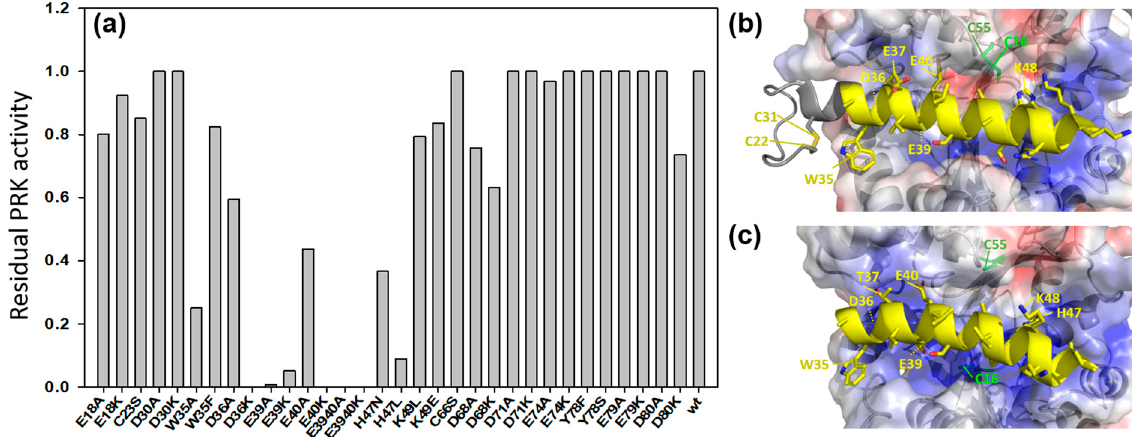
Figure 5. ( a ) Residual activity of PRK recovered after incubation with various CP12 mutants during three days at 4 °C (the absolute PRK activity without incubation is reported in Figure 4 and was 120 U·mg − 1 ). The PRK activity was measured and compared with PRK activity of the enzyme incubated without CP12. Residual activity was determined as the ratio of the difference between PRK activity of the PRK-mutated CP12 mixture and of PRK alone. ( b ) Crystallographic structure of oxidized and inactive PRK in complex with CP12 in the ternary complex of A. thaliana GAPDH-CP12-PRK (pdb: 6 KEZ) [29]. ( c ) Structural model of A34–H47 helix from the C. reinhardtii CP12 (DOI: 10.5452/ma-cr3 y1) [32] docked onto the crystallographic structure of reduced and active C. reinhardtii PRK (pdb: 6 H7 G; [30]), based on the A. thaliana ternary complex (pdb:6 KEZ) as template. Blue: positively charged surface. Red: negatively charged surface.